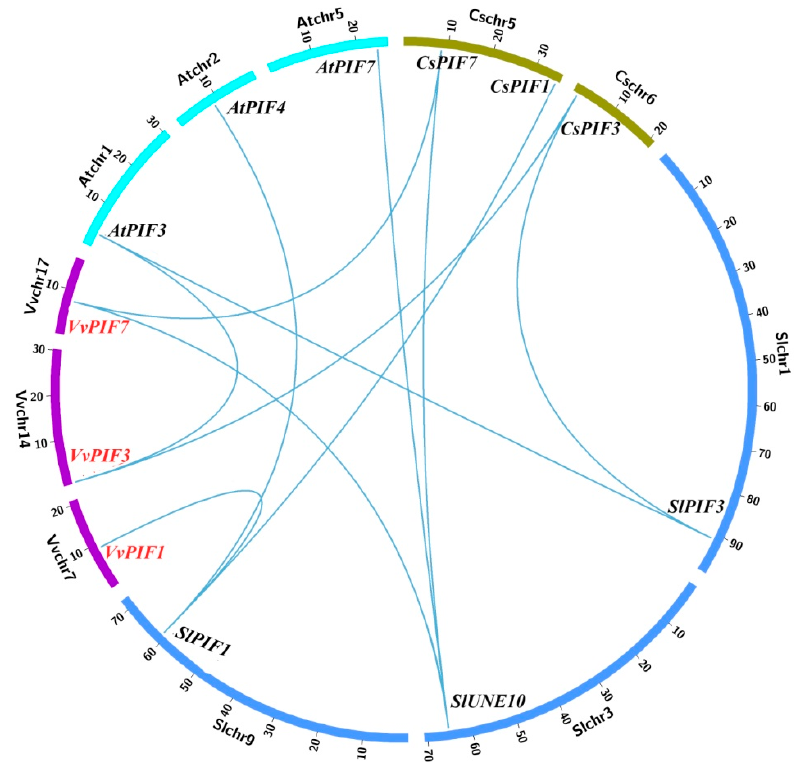
Figure 2. Syntenic block among PIFs from V. vinifera , A. thaliana , S. lycopersicum , and C. sinensis . The chromosomes of V. vinifera , A. thaliana , S. lycopersicum , and C. sinensis are displayed in purple, bright green, blue, gray green. The putative orthologous PIFs are connected by light blue.